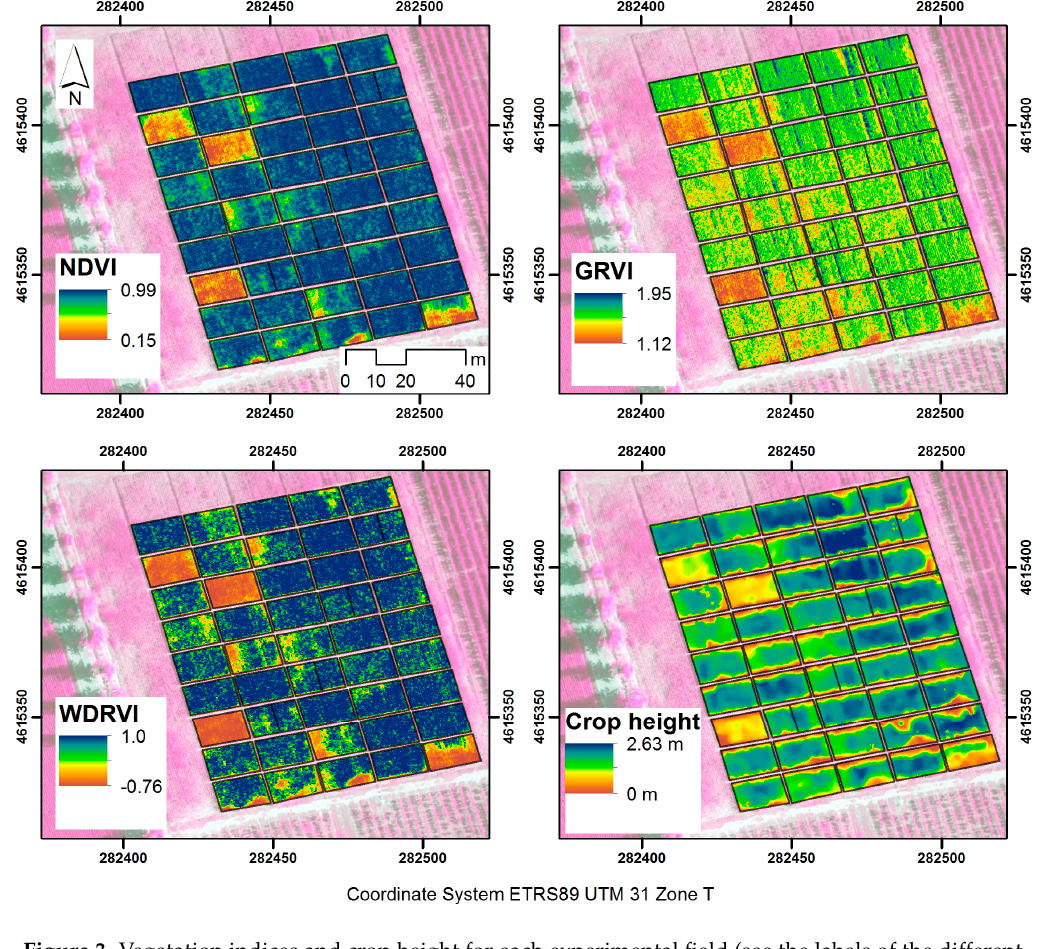
Figure 3. Vegetation indices and crop height for each experimental field (see the labels of the different nitrogen fertilizer treatments in Figure 1).